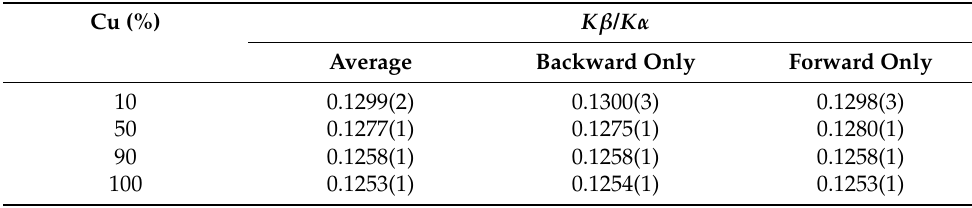
Table 2. Simulated K β / K α intensity ratio for 1 µm thick samples induced by monoenergetic radiation, calculated for backward and forward direction and weighted average of